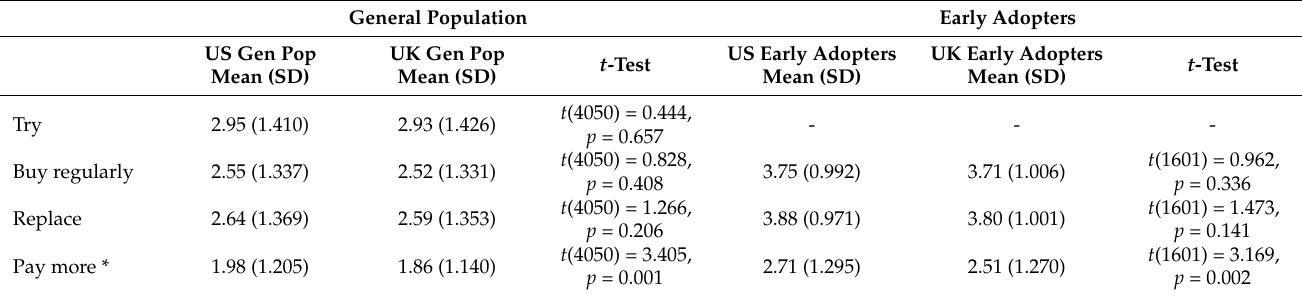
Table 4. Comparison of adoption measures between the US and the UK. General Population Early